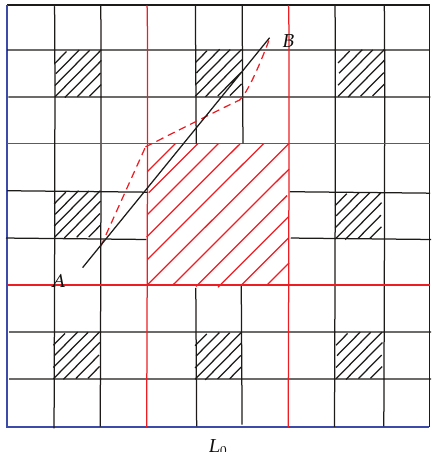
Figure 9: The distance between two points in a discontinuous